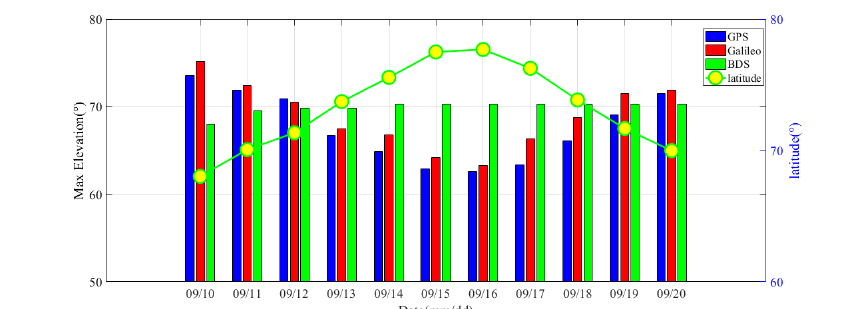
Figure 4. Relationship between satellite maximum elevation angle and latitude of the ship’s position.